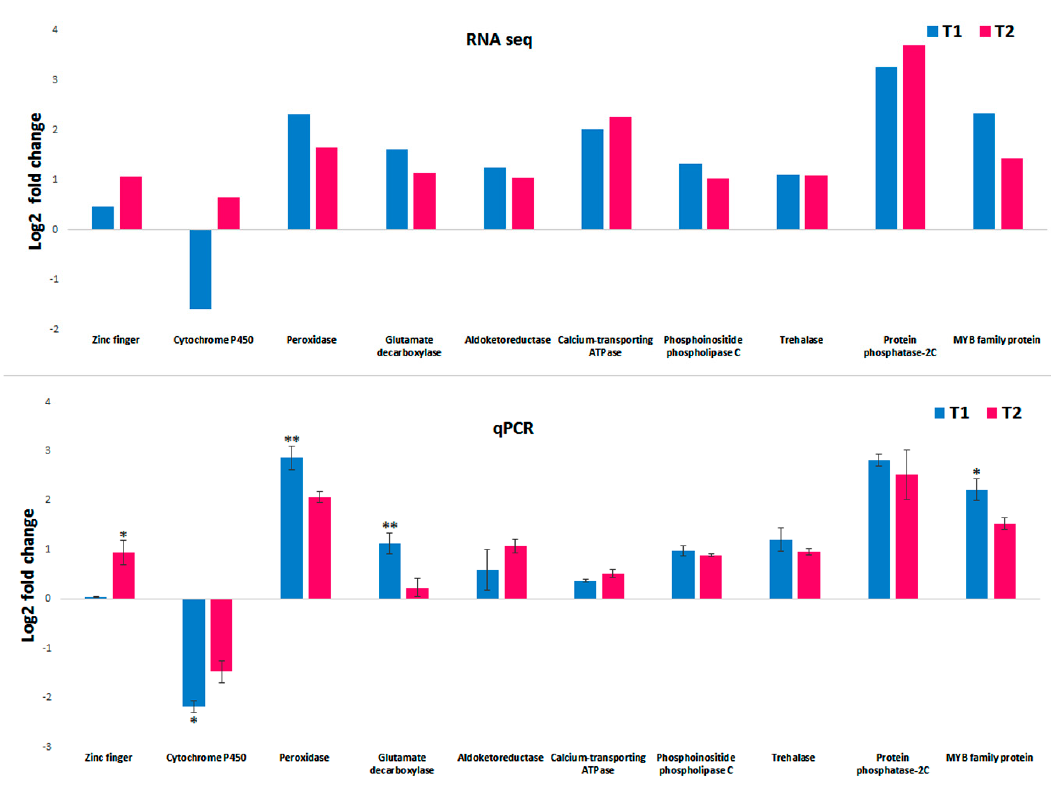
Figure 11. Validation of selected transcript from RNA seq using qPCR. The graph on the top shows the Log2FC of ten selected transcript DGE expressions in the T1 and T2 sample. The bottom graph represents the corresponding qPCR fold change in the T1 and T2 samples. The error bar represents the standard deviation. The difference between the means were calculated by Student’s t-test (*: p ≤ 0.05, **: p ≤ 0.01). T1: 48 h PEG treatment; T2: 72 h PEG treatment.